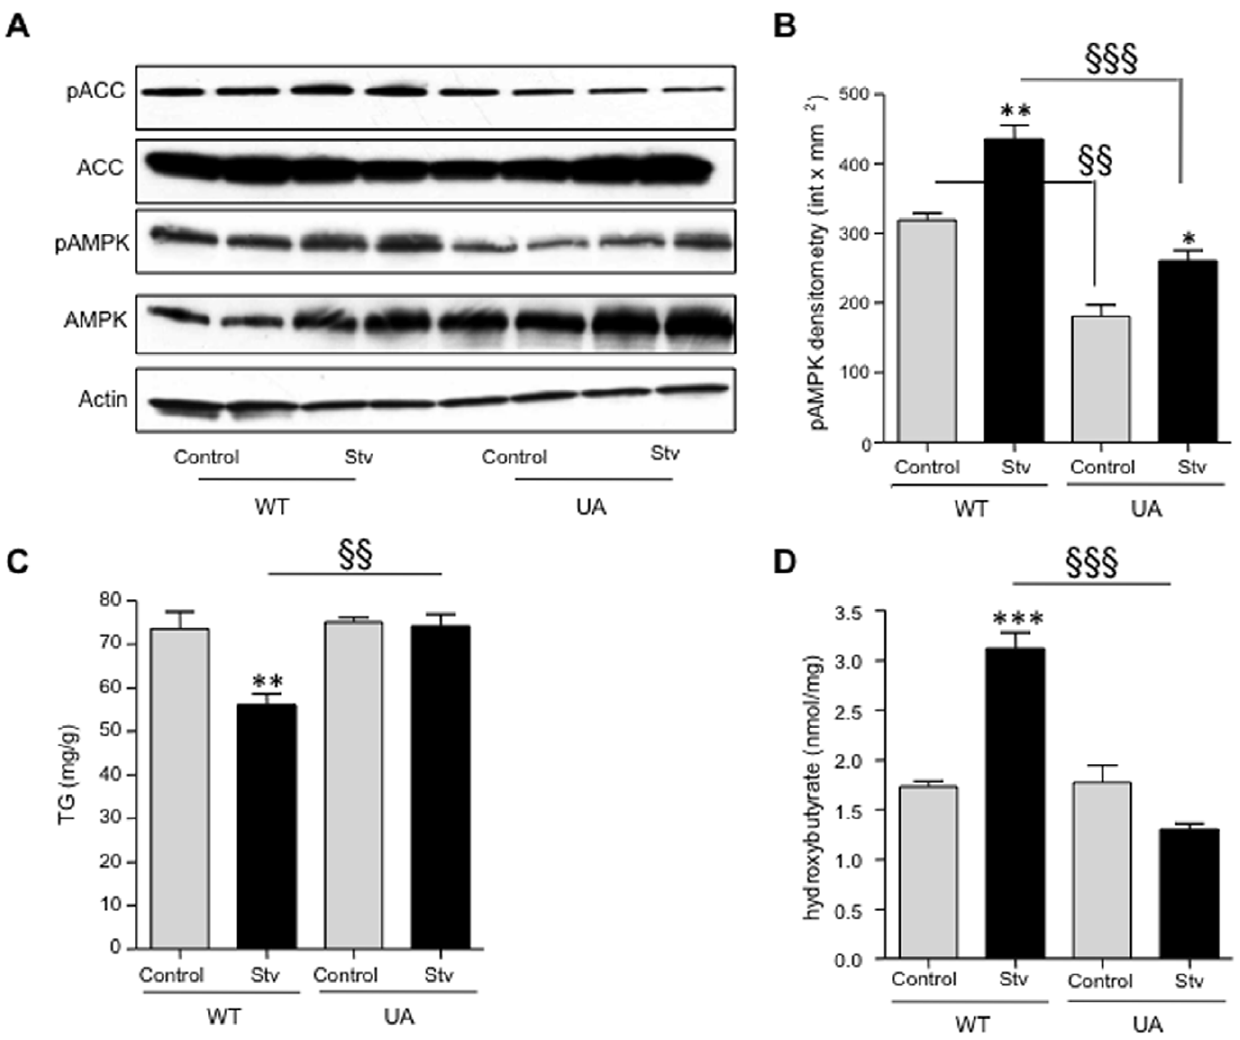
Figure 7. Uric acid down-regulates starvation-induced AMPK activation. HepG2 cells were exposed to 750 m mol/L uric acid for 48 hours prior 3 hour starvation (stv) and AMPK phosphorylation, intracellular TG and intracellular b -hydroxybutyrate levels were analyzed after starvation time. A–B) representative western blot and densitometry of phosphorylated AMPK in control and uric acid exposed cells undergoing starvation. *p , 0.05, **p , 0.01 versus control, 11 p , 0.01 control vs control, 111 p , 0.001 stv vs stv C) Intracellular TG levels in control and uric acid exposed